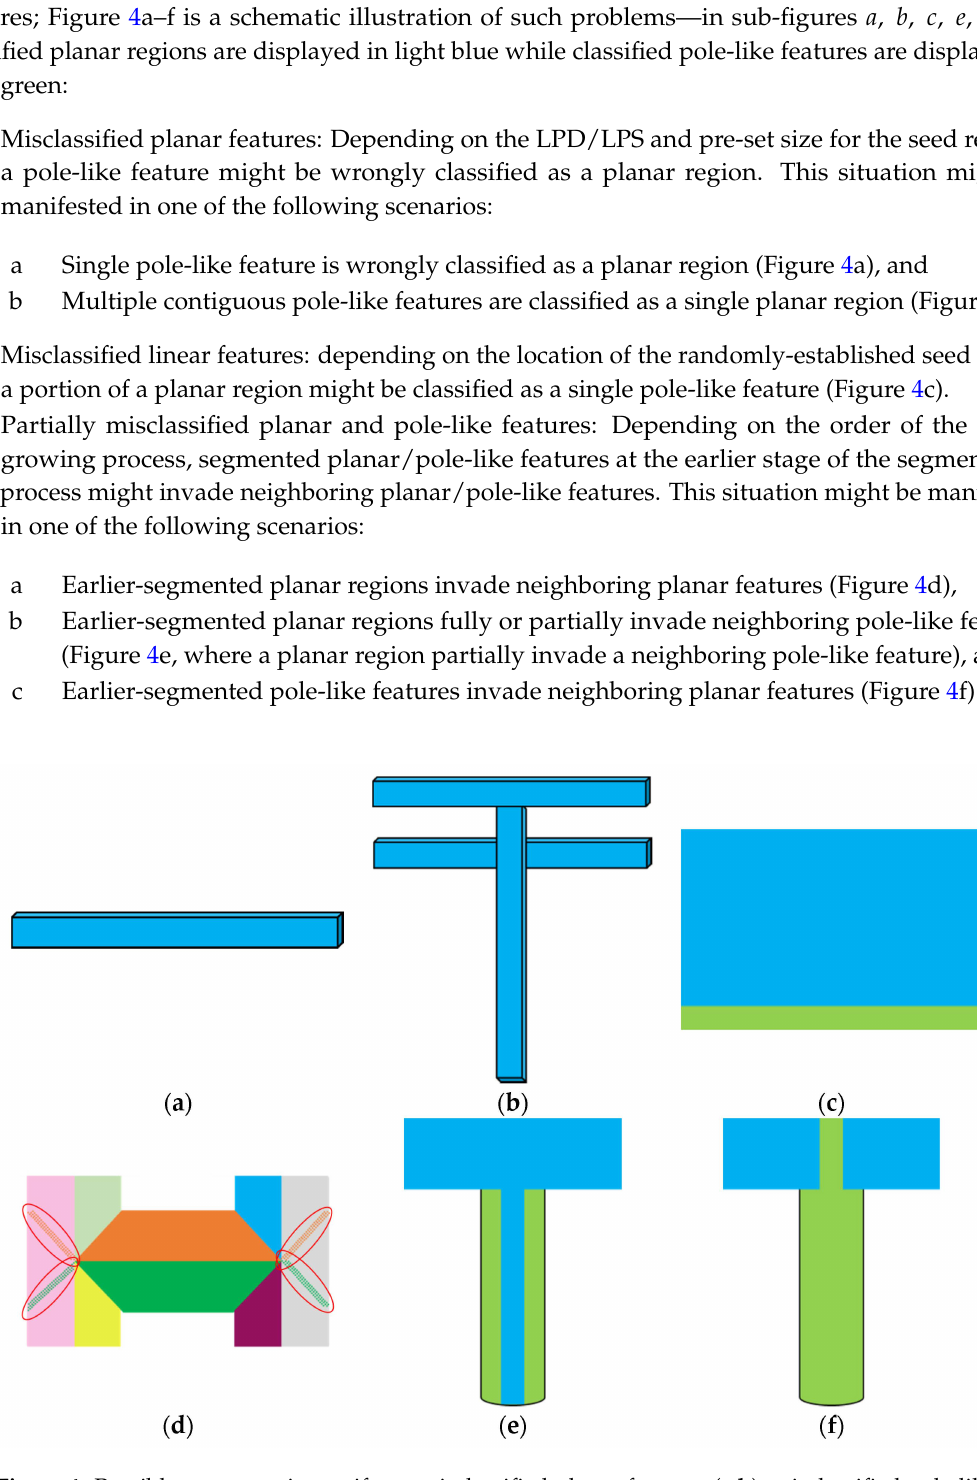
Figure 4. Possible segmentation artifacts; misclassified planar features ( a , b ); misclassified pole-like feature ( c ); partially misclassified planar features ( d , e ); and partially misclassified pole-like feature ( f )—planar and pole-like features are displayed in light blue and light green, respectively, in subfigures ( a ), ( b ), ( c ), ( e ), ( f